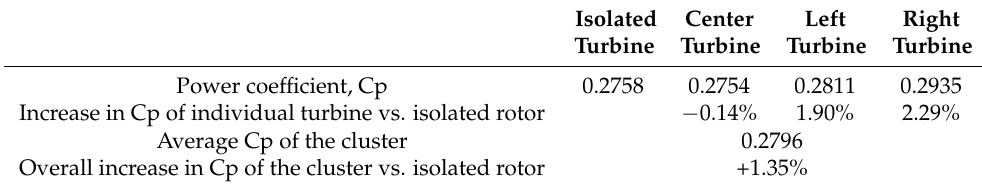
Table 2. Simulation results at 12 turbine diameter spacing.